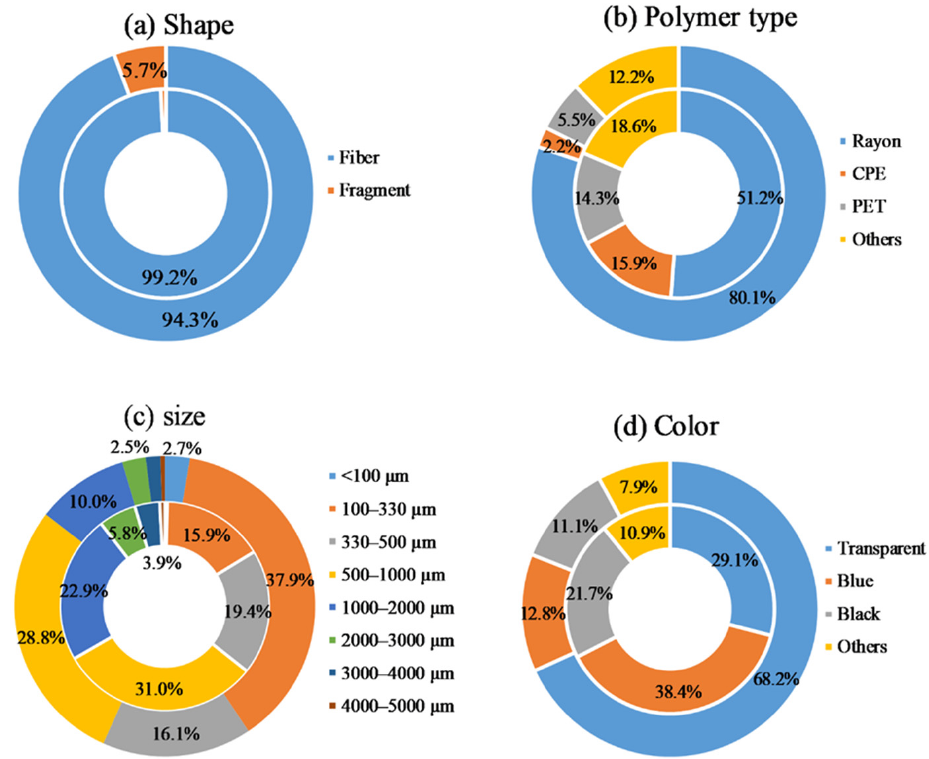
Figure 3. MPs’ characteristics in the effluent from WWTPs in Qingdao, China: ( a ) shape; ( b ) polymer types; ( c ) size distribution; ( d ) color. Inner ring shows the effluent in winter; outer ring shows the effluent in summer.